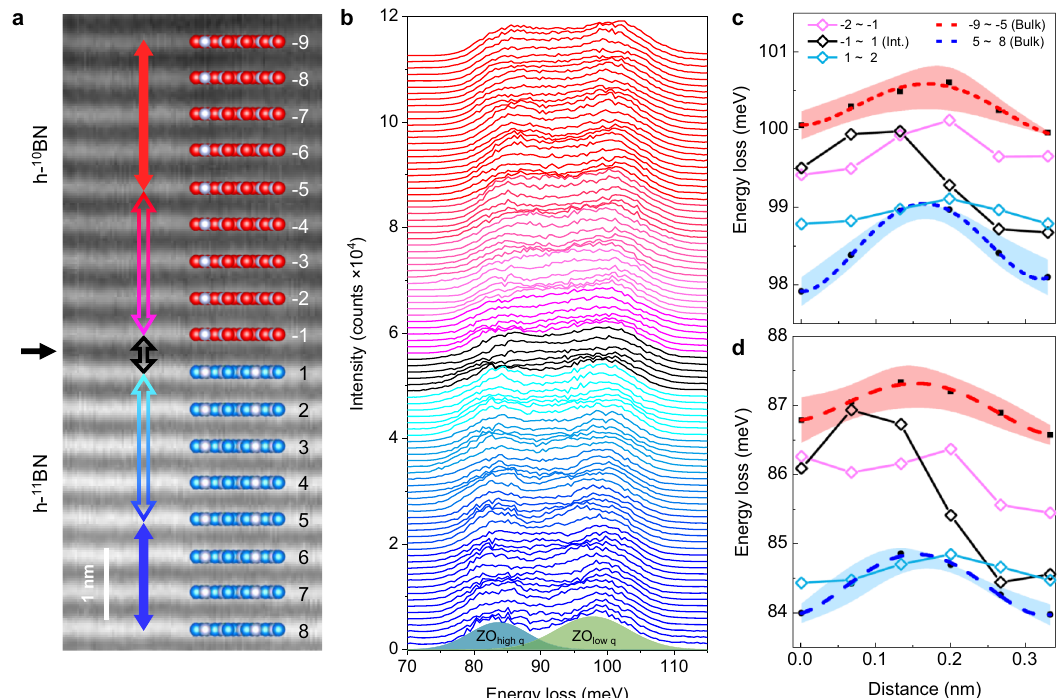
Fig. 3| Vibrationenergychangebetweenatomiclayers.a HAADFimage andthe schematic of the structure of the h- 10 BN/h- 11 BN interface. Each atomic layer is labeledasthenumberoflayerawayfrominterface(plusforh- 11 BNandminusforh- 10 BN).Theinterfaceisbetween − 1and1layer. b EELspectraofZOphononsfromthe h- 10 BN to h- 11 BN. The acquision position of spectra are labeled in a by the arrows with the same color, i.e. the spectra of interface (layer No. − 1 to 1) are shown in black, the adjacent layers to the interface (layer No. − 2 to − 1 and No. 1 to 2) are shown in magenta and cyan, and the bulk h- 10 BN (layer No. − 9 to − 5) and h − 11 BN (layerNo. 5to8)areshowninred and blue.No. “ nton+1 ” lablethe spatrathat are